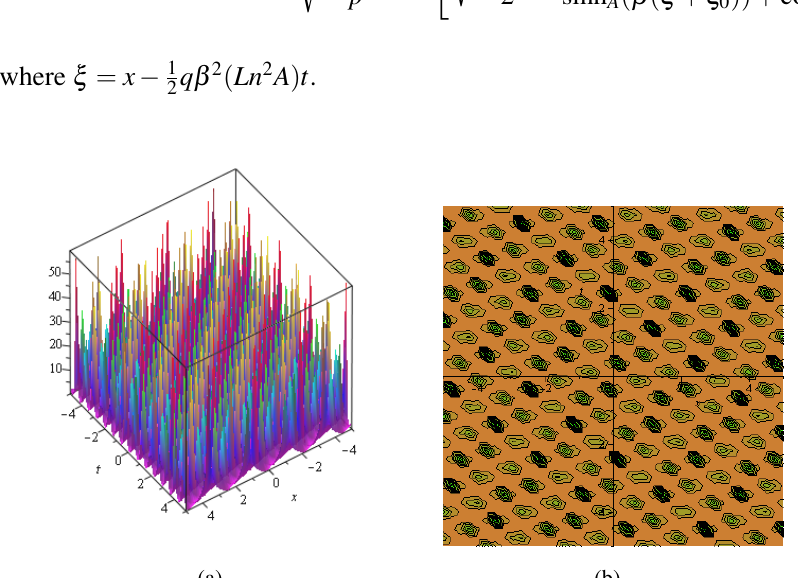
Fig. 3 Graphics of the solution equation (28) ( u + β = 4 , α = 2 , σ = 3 , A = 2 . 6 , p = 1 , q = 0 . 9 and ξ 0 = 0 (a) 3D plot and (b) contour plot.